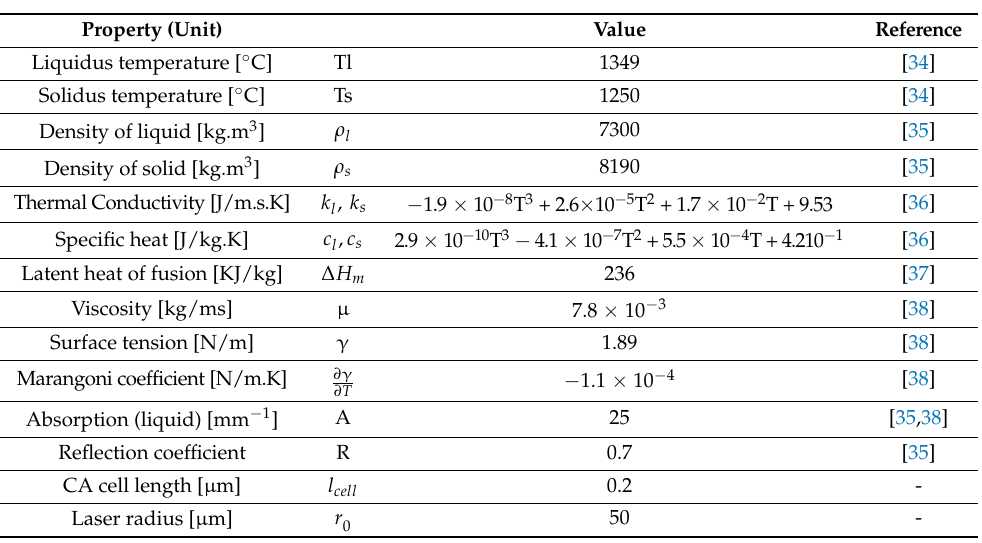
Table 2. Physical parameters used in the CA